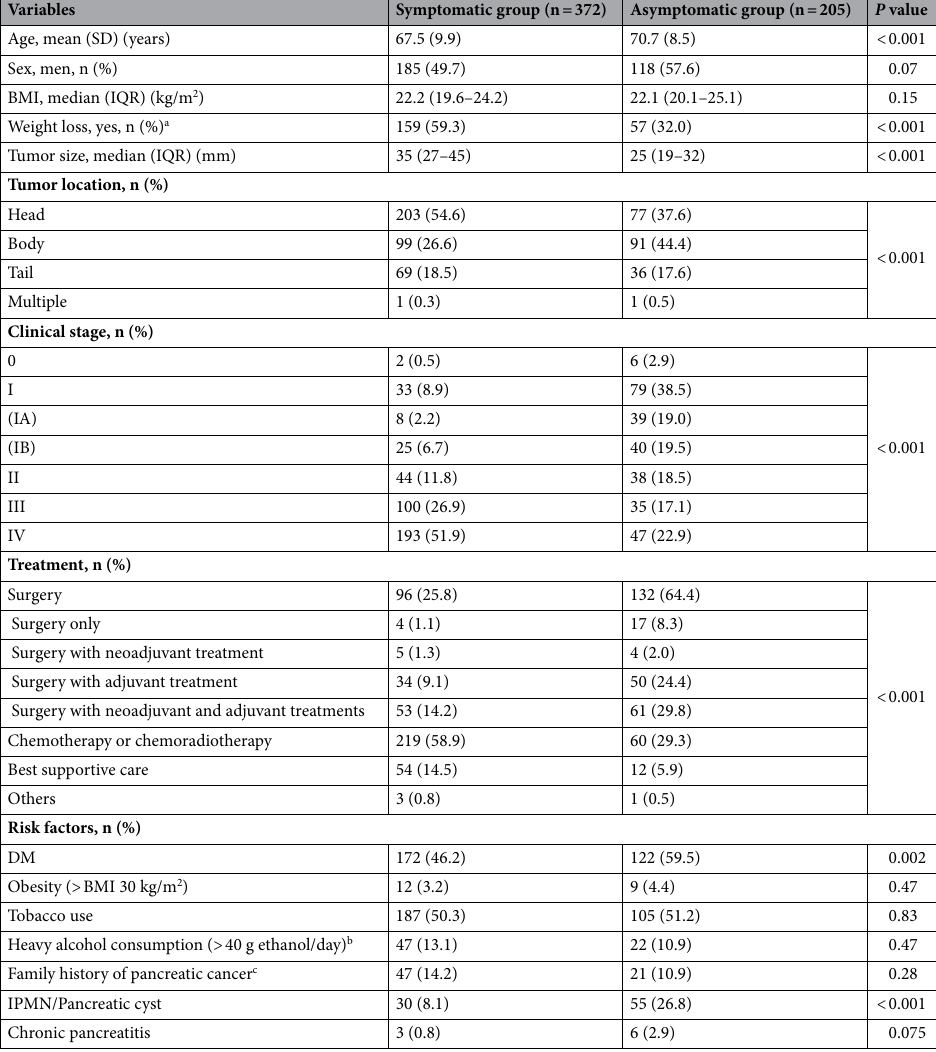
Table 2. Comparison of the clinical characteristics between symptomatic and asymptomatic patients. SD standard deviation, BMI body mass index, IQR interquartile range, DM diabetes mellitus, IPMN intraductal papillary mucinous neoplasm. a Data from 268 symptomatic and 178 asymptomatic patients. b Data from 360 symptomatic and 201 asymptomatic patients. c Data from 330 symptomatic and in 192 asymptomatic